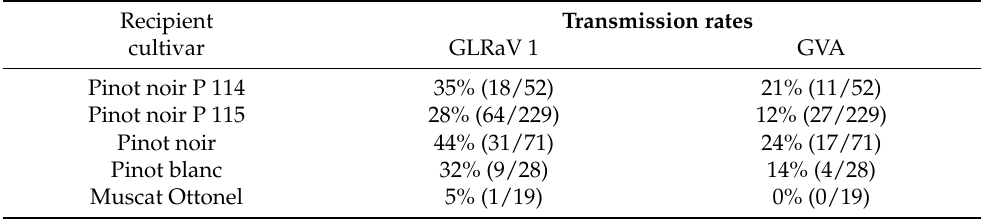
Table 6. Transmission rates of GLRaV 1 and GVA by L1 and L2 of Parthenolecanium corni , according to cultivars of recipient vines, after transmission experiments. In brackets, number of positive recipient vines/number of inoculated